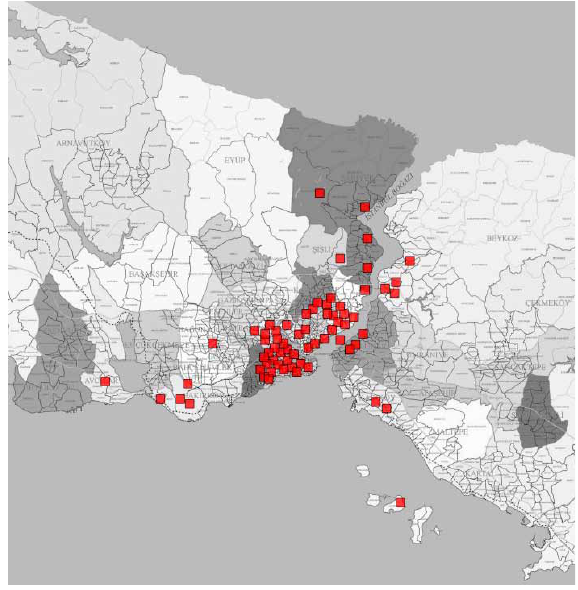
Table 1. Comparison of the number of museums and visitors. (Turkish Museums report 2013)